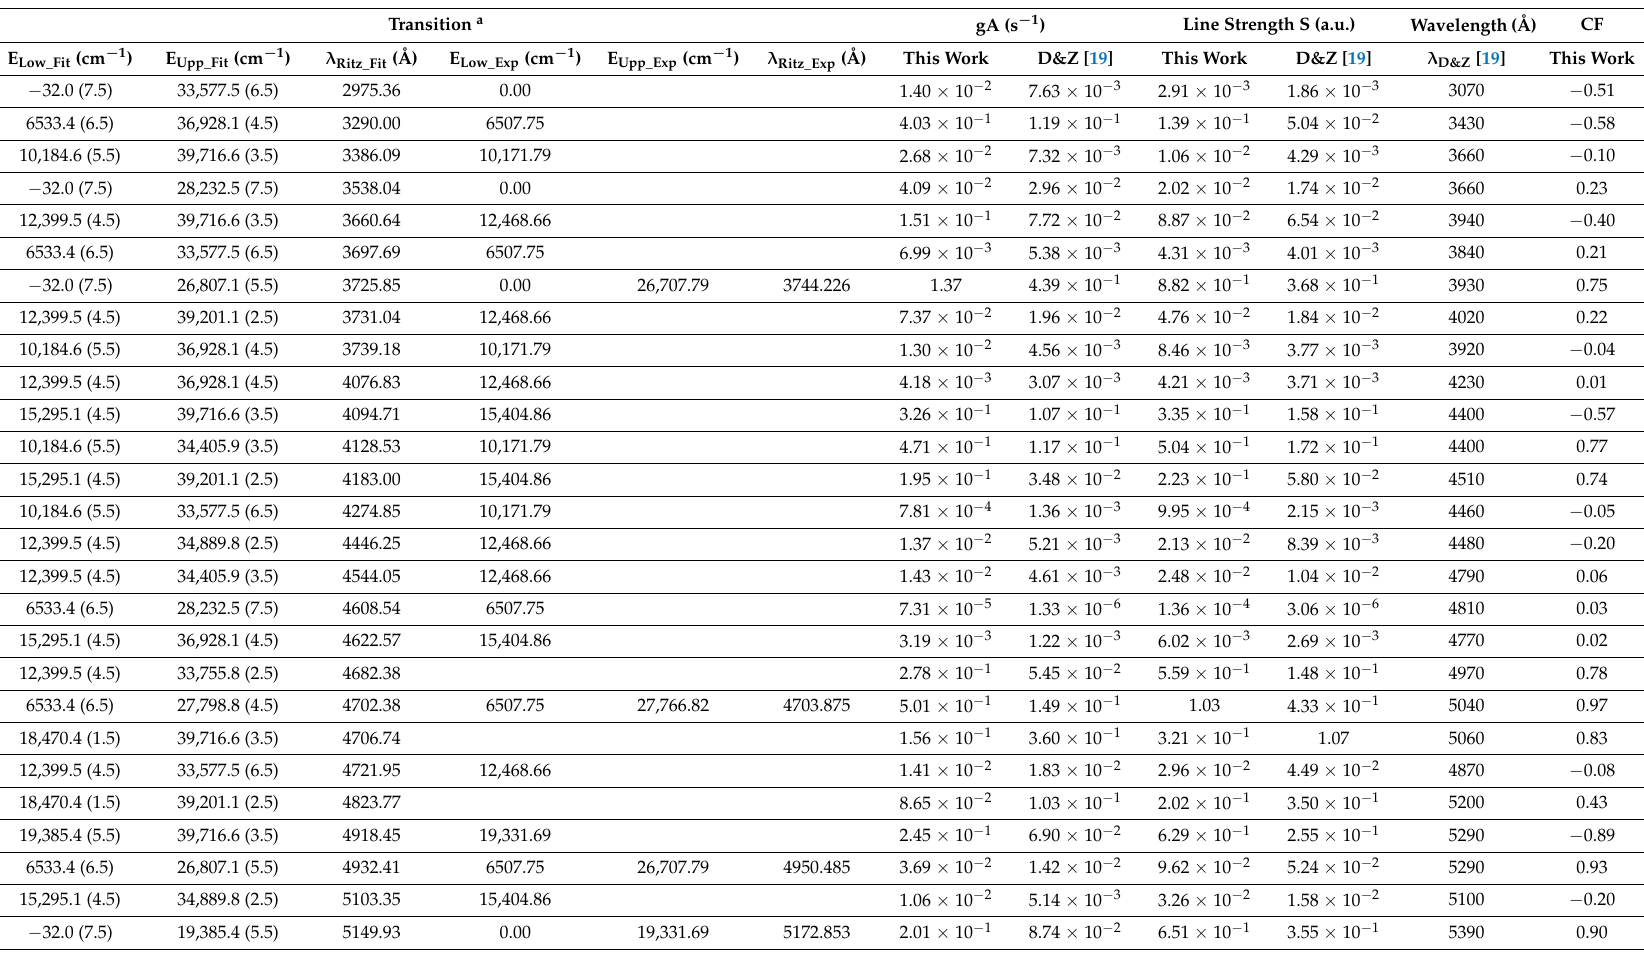
Table 5. Semi-empirical transition probabilities gA (s − 1 ) and line strengths for electric quadrupole (E2) transitions within the Er IV ground-state configuration 4f 11 . Comparison with ab initio results from Dodson and Zia [19]. All wavelengths are in vacuum. Each energy level is specified by its energy value, followed by the quantum number J between the parentheses [14]. CF is the cancellation factor as defined by Equation (14.107), p. 432 in [15] and derived from our